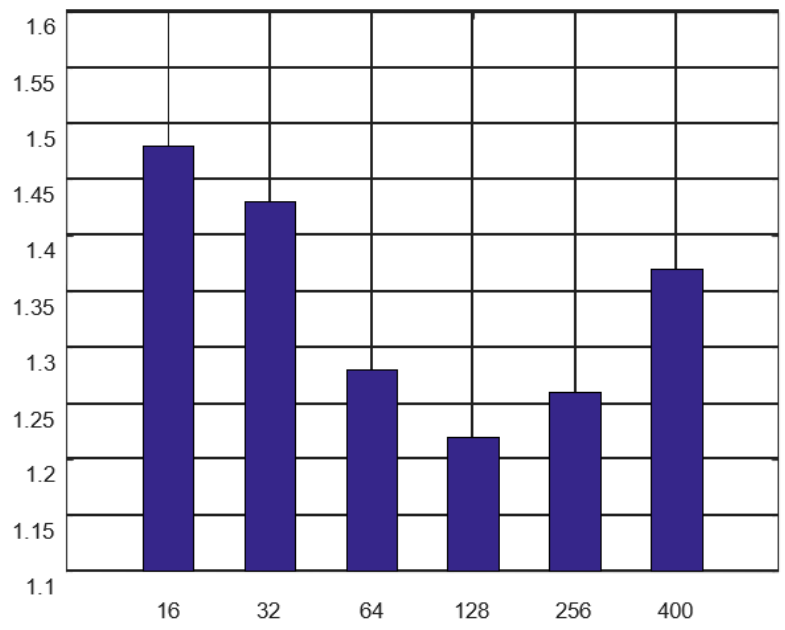
Figure 9. Localization effect of different convolution kernel numbers. Initially, with an increase in the number of convolution kernels, the positioning pre- cision of the model was greatly improved. The best positioning effect was obtained by using 128 convolution kernels. As the number of convolution kernels continued to increase, the model positioning performance decreased. Additionally, when the number of model parameters increased dramatically, the training time became significantly longer. Conse- quently, the number of convolution kernels in the TCN space-time feature extractor was set to 128. For DNN regressors, different network structures affected the performance of the model. The experimental comparison results are shown in Figure